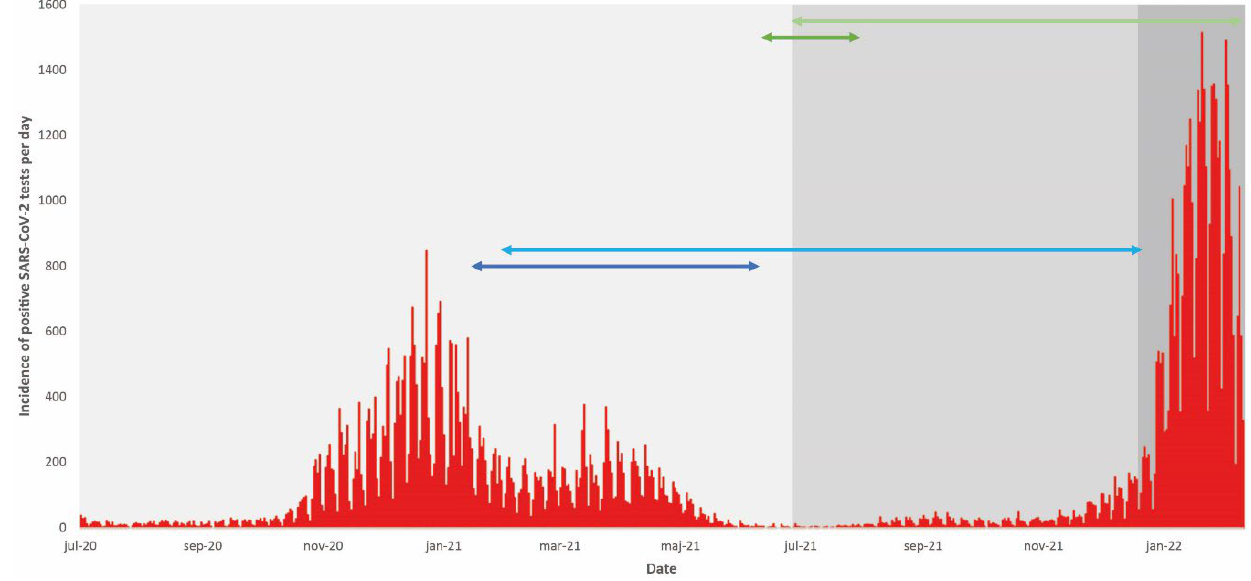
Figure 1. Incidence of positive SARS-CoV-2 tests (red stacks) in the total vaccinated population during the study period. The dominating SARS-CoV-2 variant of concern (light grey, grey, and dark grey areas representing the periods dominated by the Alpha, Delta and Omicron variants, respectively) is indicated, as well as the time periods for vaccination and follow-up for the prioritized risk population (dark blue line and light blue line, respectively) and the non-prioritized population (dark green line and light green line, respectively). Table 1. Age and sex in the case-control population vaccinated with the BNT162b2 vaccine by 31 July 2021 in Östergötland, Jönköping, and Skåne counties, Sweden ( n = 76,042) displayed by vaccination phase (prioritized first phase and non-prioritized second